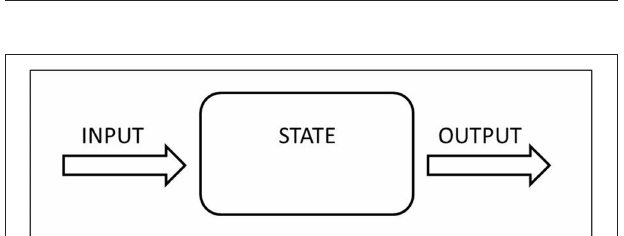
FIGURE 1 | Representation of sustainability and the environmental, social and economic spheres: (A) concentric circles, adapted from Mitchell (2000), (B) oriented pyramid, adapted from Pulselli et al. (2015).